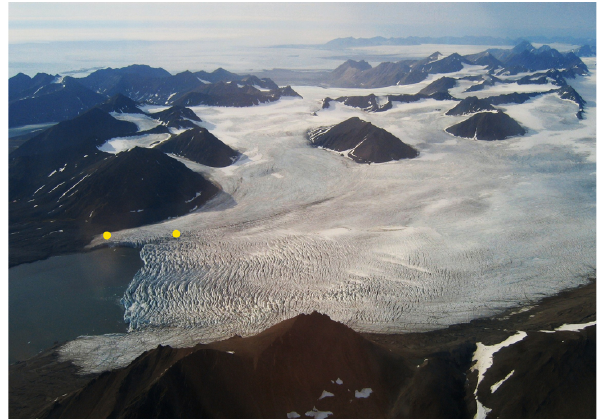
Fig. 1. Aerial of the lower part and calving front of Hansbreen. The yellow dots indicate locations were fossil peat was found at the surface in 1997 (discussed in Sect. 4). Courtesy of SLICES Project (Swansea Glaciology Group, Swansea University,